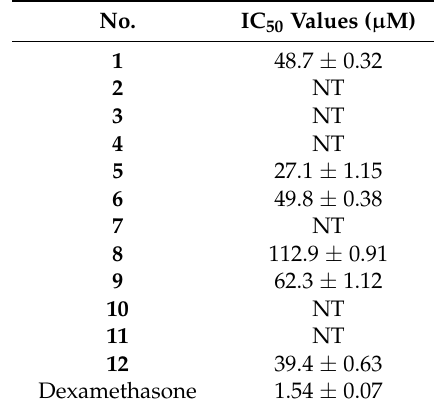
Table 3. Inhibitory effects of compounds 1 – 12 on NO production by LPS-stimulated RAW264.7